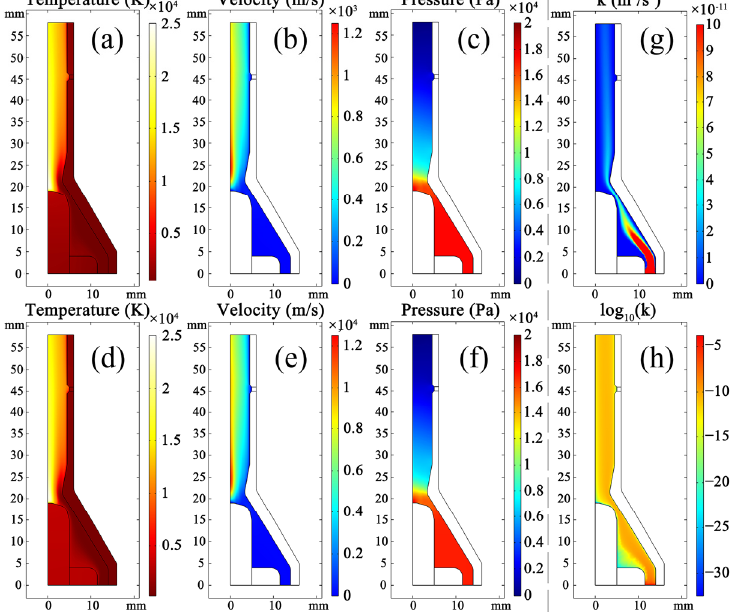
Figure 3. Results of arcing simulation for SinplexPro™ plasma spray gun; laminar model: ( a ) temperature distribution, ( b ) velocity distribution, ( c ) pressure (relative to 101,325 Pa); turbulent model: ( d ) temperature distribution, ( e ) velocity distribution, ( f ) pressure distribution, ( g ) turbulent kinetic energy (<1 × 10 10 ), and ( h ) turbulent kinetic energy distribution (logarithmic scale).